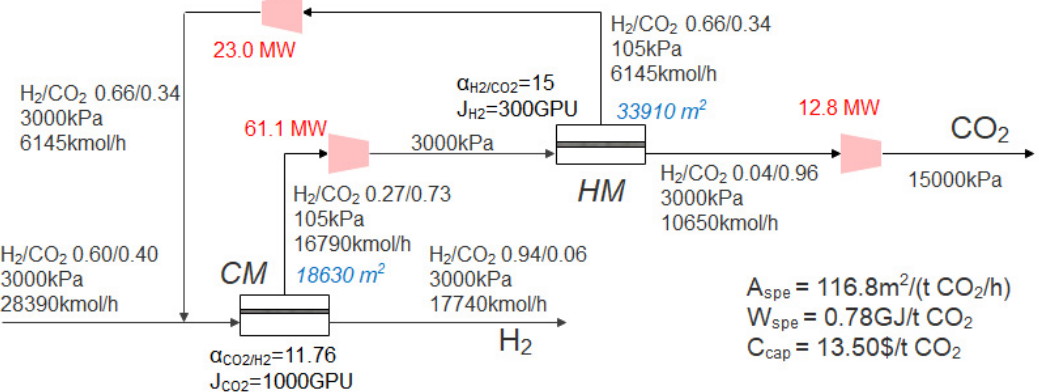
Figure 6. The optimal process when using the commercial membrane in Table 2, with feed pressure fixed at 3000 kPa.